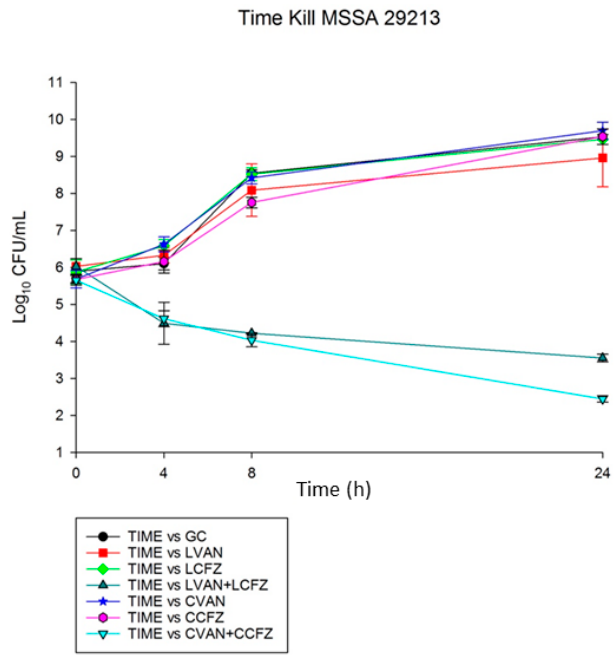
Figure 6. Time kill assay for MSSA 29213 strain.